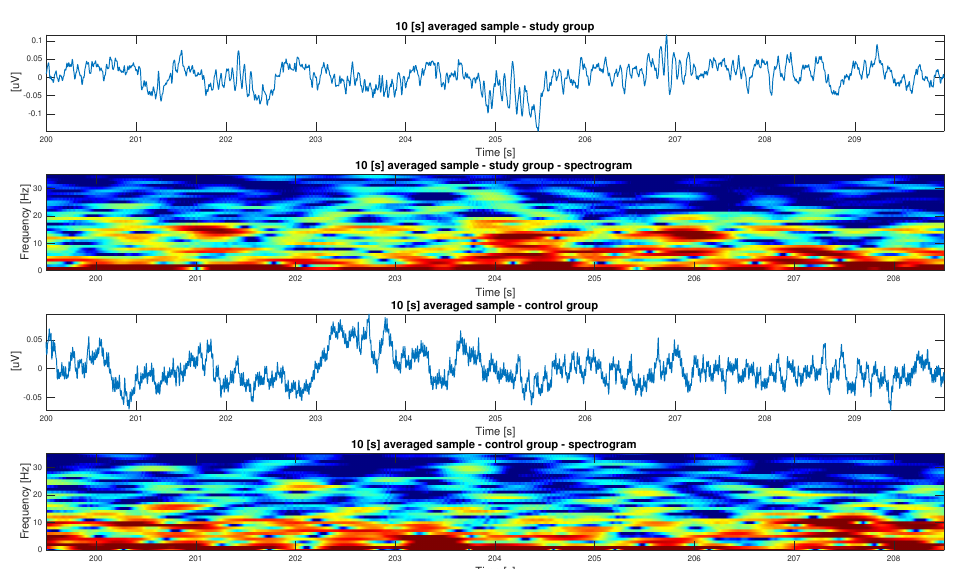
Figure 6. Averaged sample study group ( top ) and control group ( bottom )—time series and spectro- gram (10